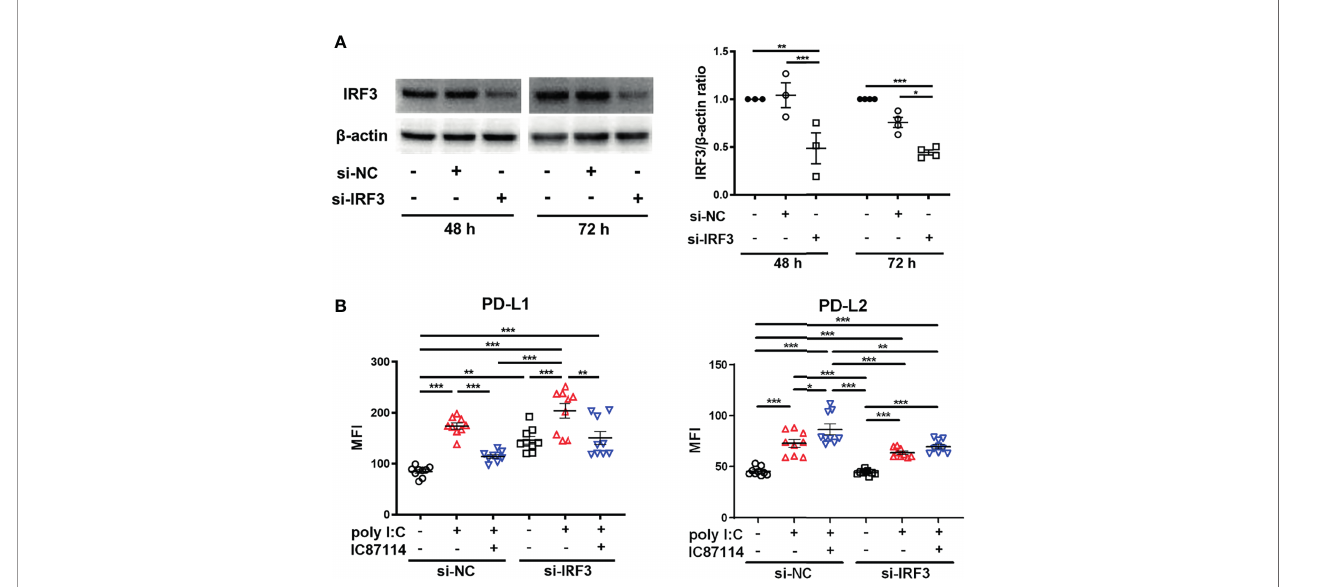
FIGURE 6 | siRNA knockdown of IRF3 counteracts enhancement of poly I:C – induced PD-L2 expression by a PI3K d inhibitor. (A) Representative western blots of IRF3 in PBECs transfected with 10 nM IRF3 siRNA or 10 nM negative control (NC) siRNA for 48 h or 72 h. Band intensity was quantitated using densitometry. Data represent means ± SEM (n=3 – 4 per group) and pooled from two independent donors with two replicates. (B) PBECs were transfected with 10 nM IRF3 siRNA or 10 nM NC siRNA for 48 h. Transfected cells were pretreated with 10 m M IC87114 or vehicle for 1 h followed by stimulation with 1 m g/mL poly I:C for 24 h PD-L1 and PD-L2 expressions on PBECs were analyzed using fl ow cytometry. Data represent means ± SEM (n=9 per group) and pooled from three independent donors with three replicates. * p <0.05, ** p <0.01, *** p <0.001 by one-way ANOVA. MFI, mean fl uorescence intensity.